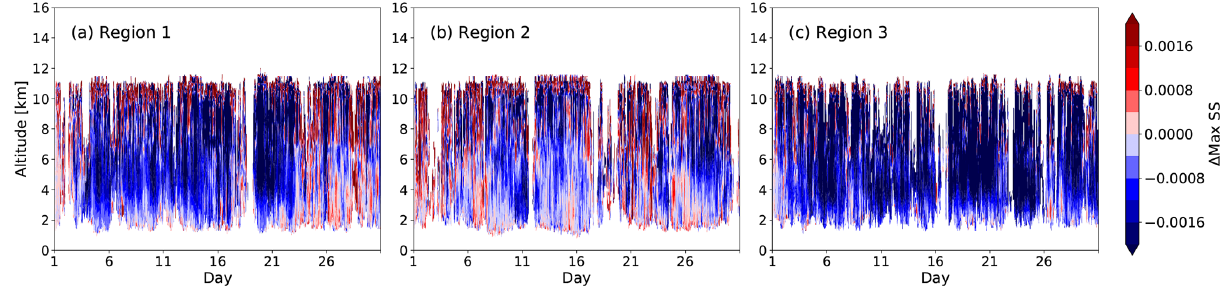
Figure A4. Differences (FIRE − NOFIRE) in maximum supersaturation S max averaged within each region, only sampled where updraft ≥ 5ms − 1 and S max >